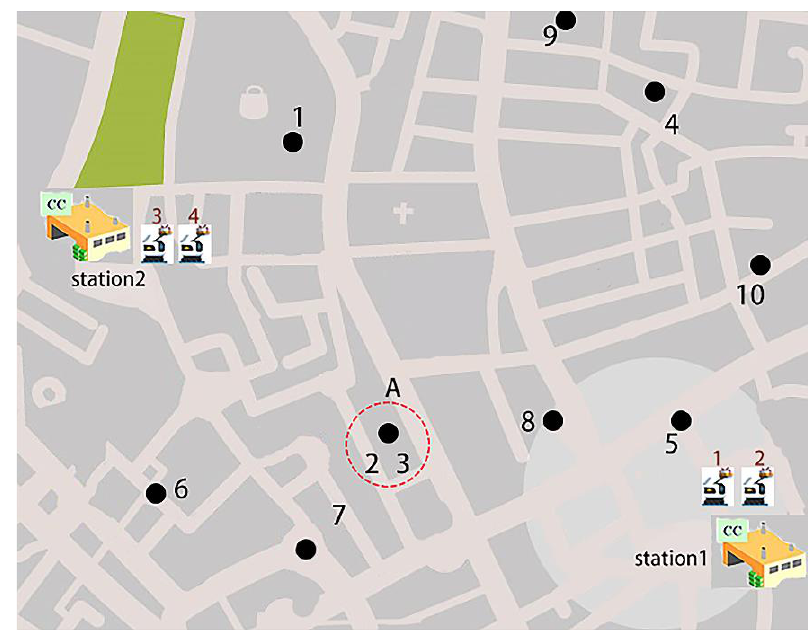
Figure 5. System layout of smart community delivery service using SR.